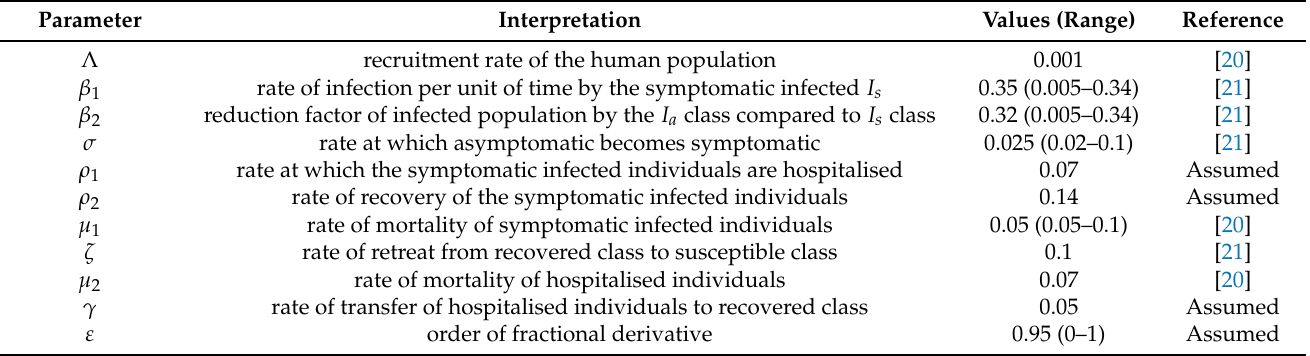
Table 1. Description of biological interpretation of model